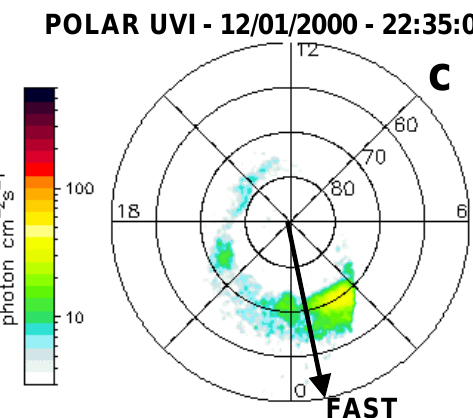
Fig. 3. Polar-UVI images in magnetic latitude-MLT coordinates. (a) 11min before the Ørsted pass. (b) at the time of the Ørsted pass 22:14:35 UT, with the Ørsted trajectory superimposed. (c) at the time of the FAST pass 22:35:08 UT, with the FAST trajectory